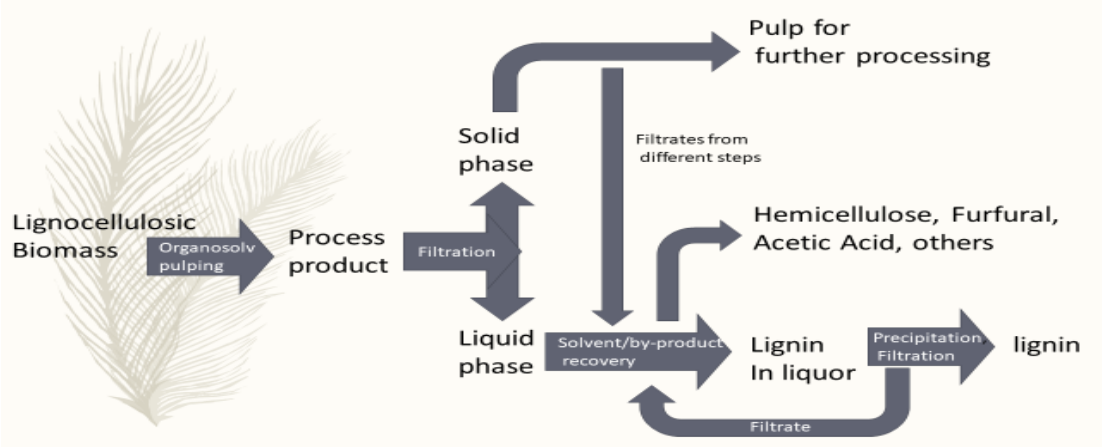
Figure 7. Representative flow diagram of general steps of Organosolv lignin production.